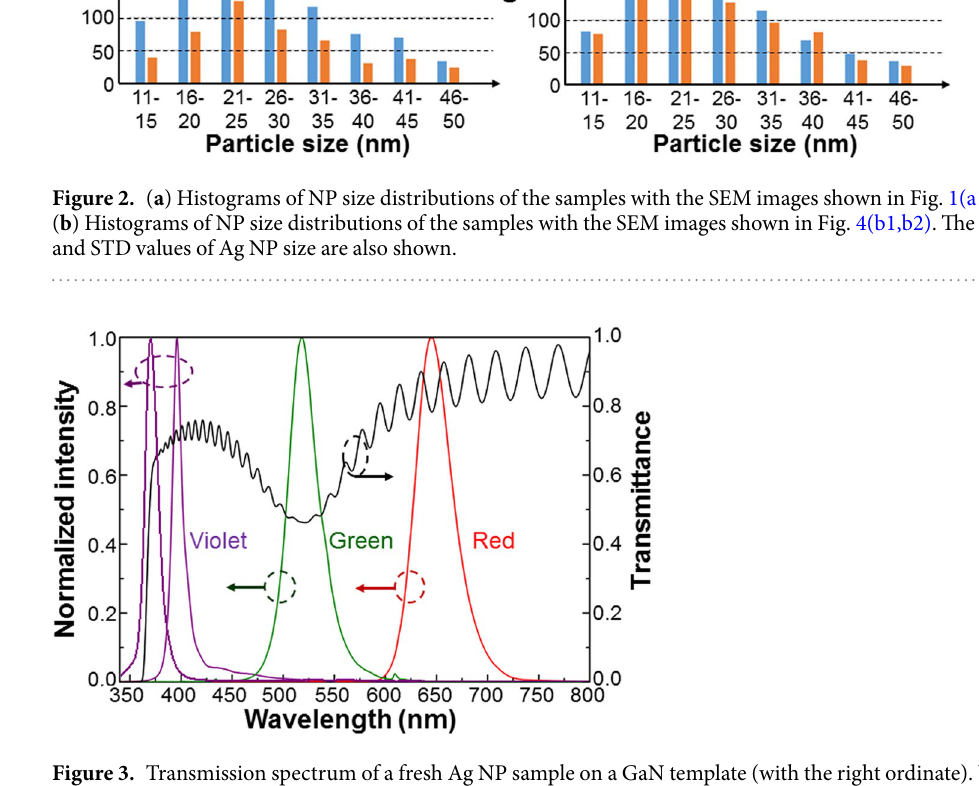
Figure 3. Transmission spectrum of a fresh Ag NP sample on a GaN template (with the right ordinate). With the left ordinate, the normalized spectra of the four LEDs used for Ag NP illumination are shown.